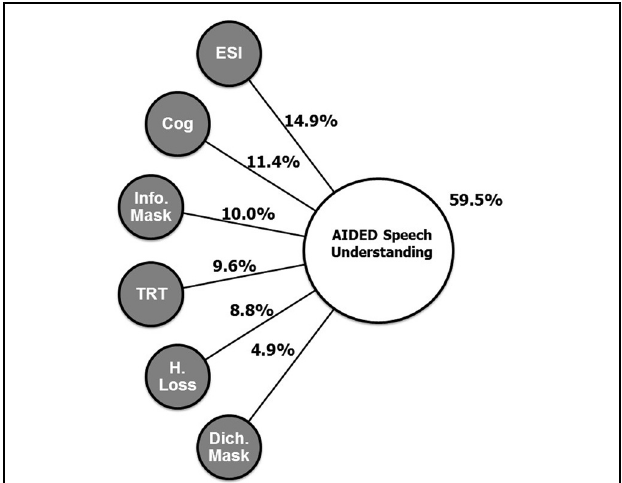
FIGURE 2 | Schematic illustration of the best-fitting regression model from the dominance analysis showing the total variance explained for aided speech understanding (59.5%) and the relative proportions of variance associated with each predictor variable. See text for further descriptions of the predictors and the